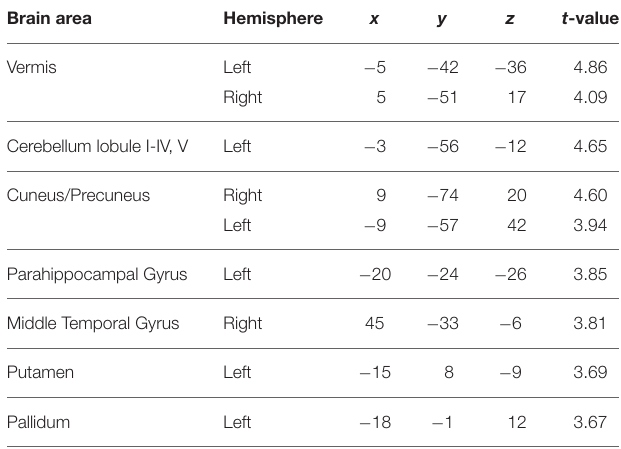
Frontiers in Neuroscience |